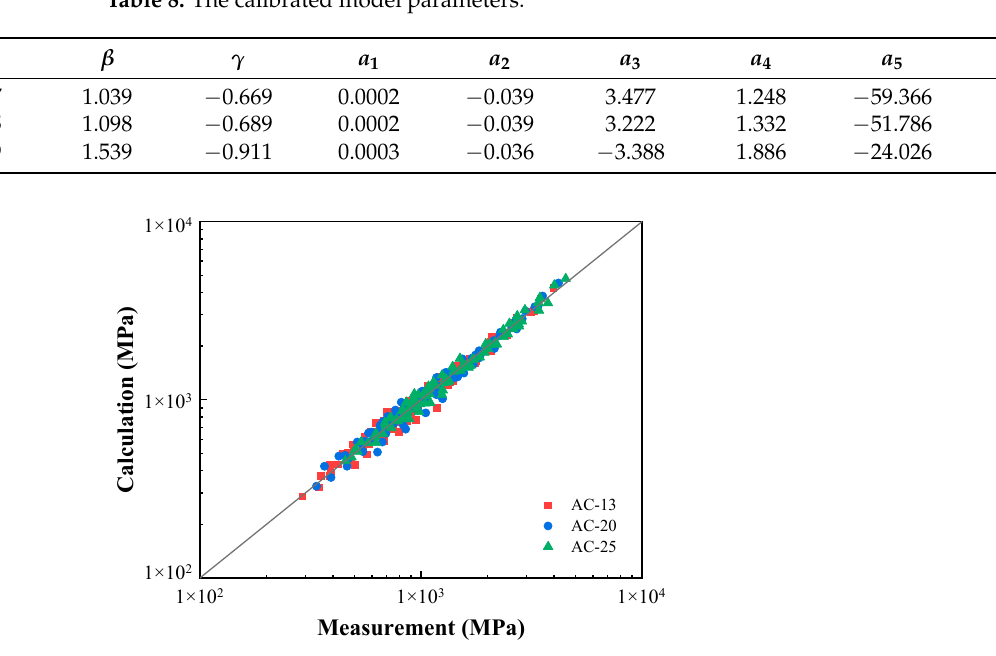
Figure 10. Comparison between the measured moduli and model calculations.